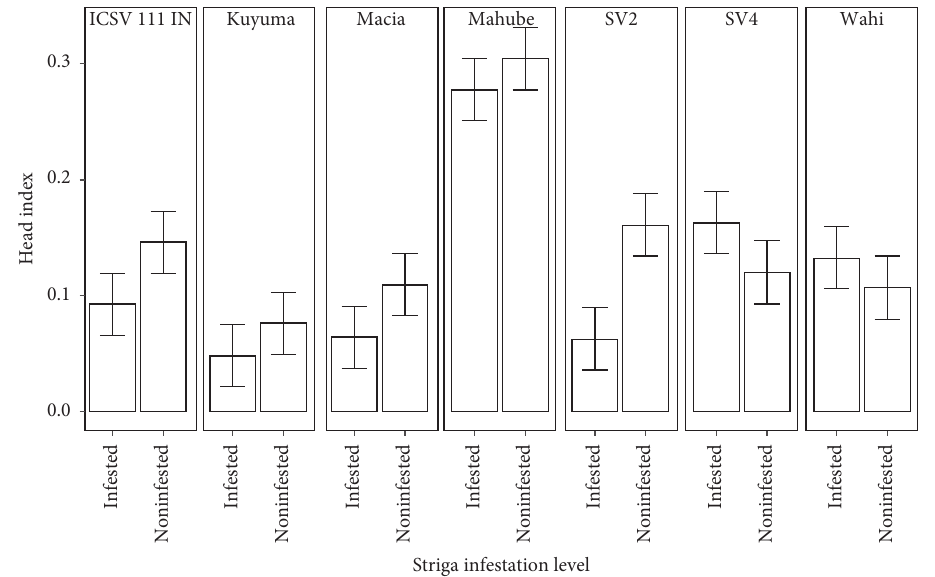
Figure 4: Effect of Striga infestation on sorghum head index. Error bars represent LSD at p < 0 . 05.